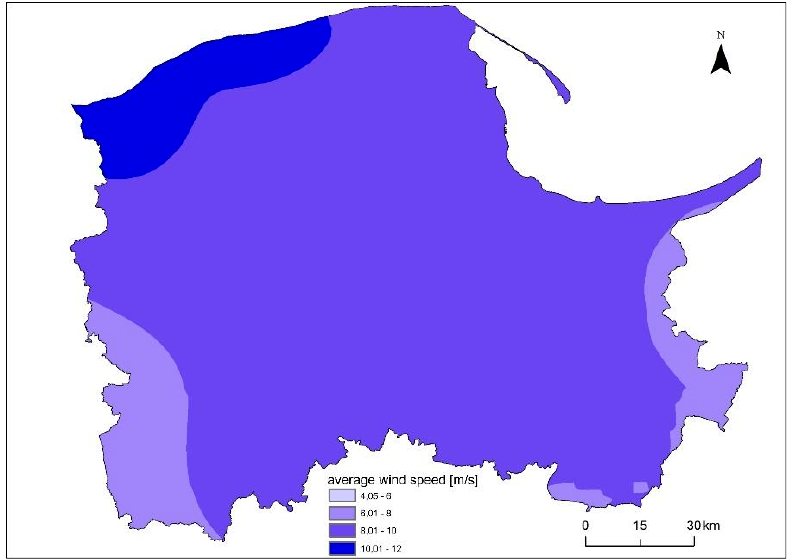
Figure 1. WS at a height of 140 m in Pomerania Voivodeship (created based on [55]).